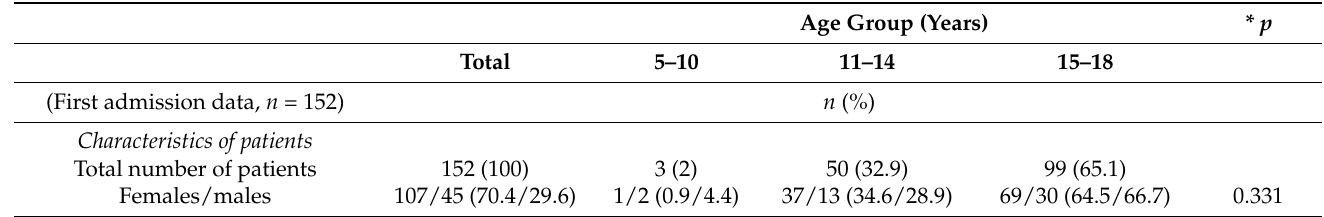
Table 2. Patients’ demographics, school, family, and environmental problems, acute stressful events, and particular influencing